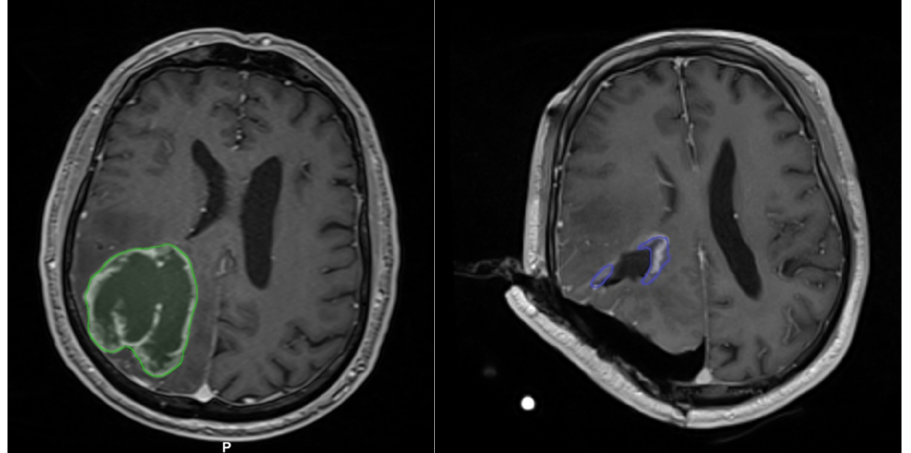
Figure 11. Preoperative ( left ) and intraoperative ( right ) MRI. Note the residual tumor outlined in violet along the edges of the surgical cavity on iMRI.